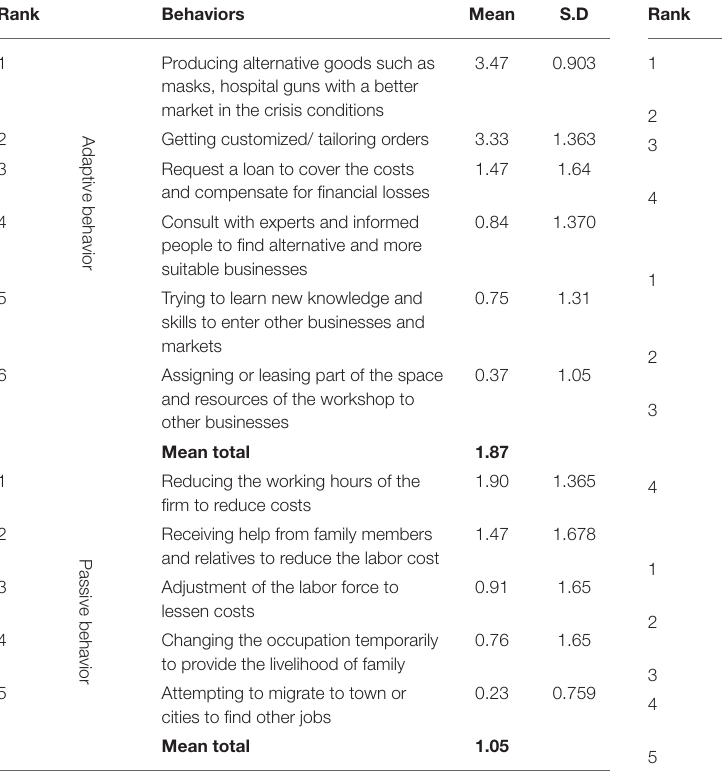
TABLE 6 | Mean and ranking of different damages in active MSEs.